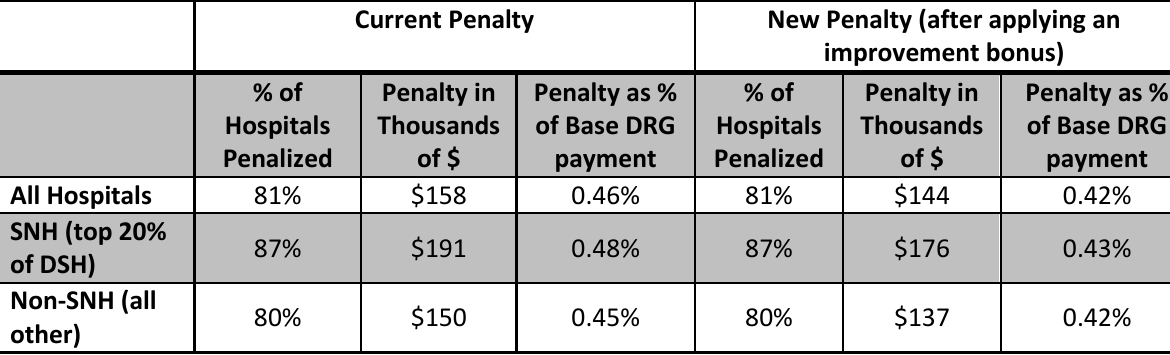
Table 5.10. Results of Rewarding